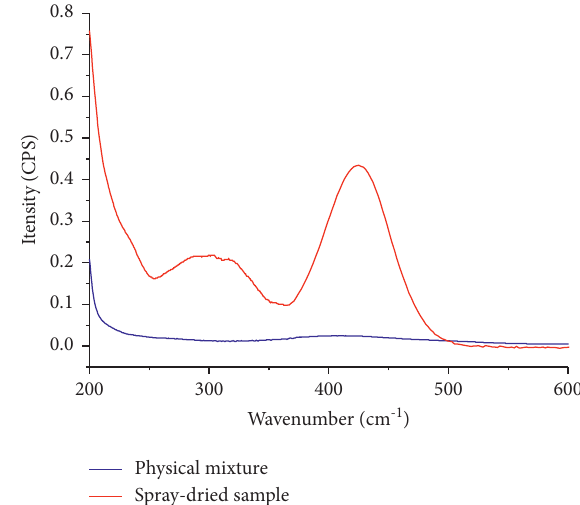
Figure 3: UV absorption curve of physical mixture and spray-dried sample at 200–600